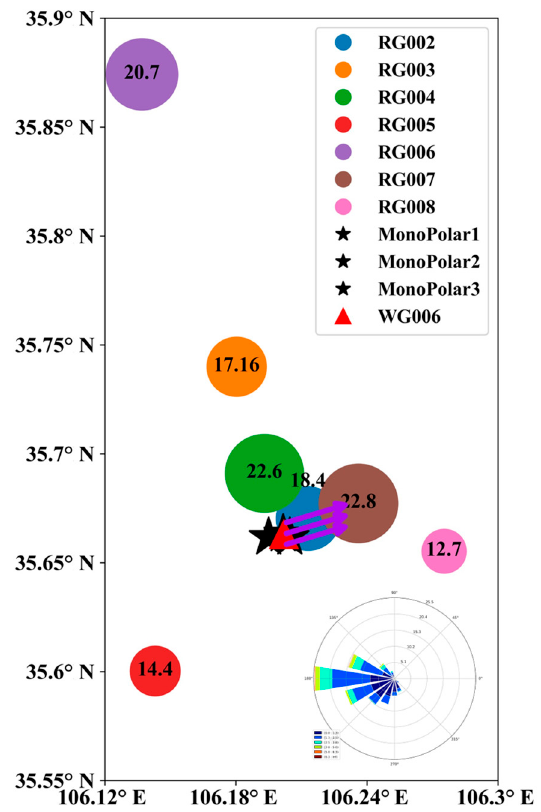
Figure 15. Wind and rain map at power-on in Liupan Mountain (30 August 2020). The direction of the arrow in the figure indicates the wind direction, and the bottom right corner of the figure is the wind rose diagram.